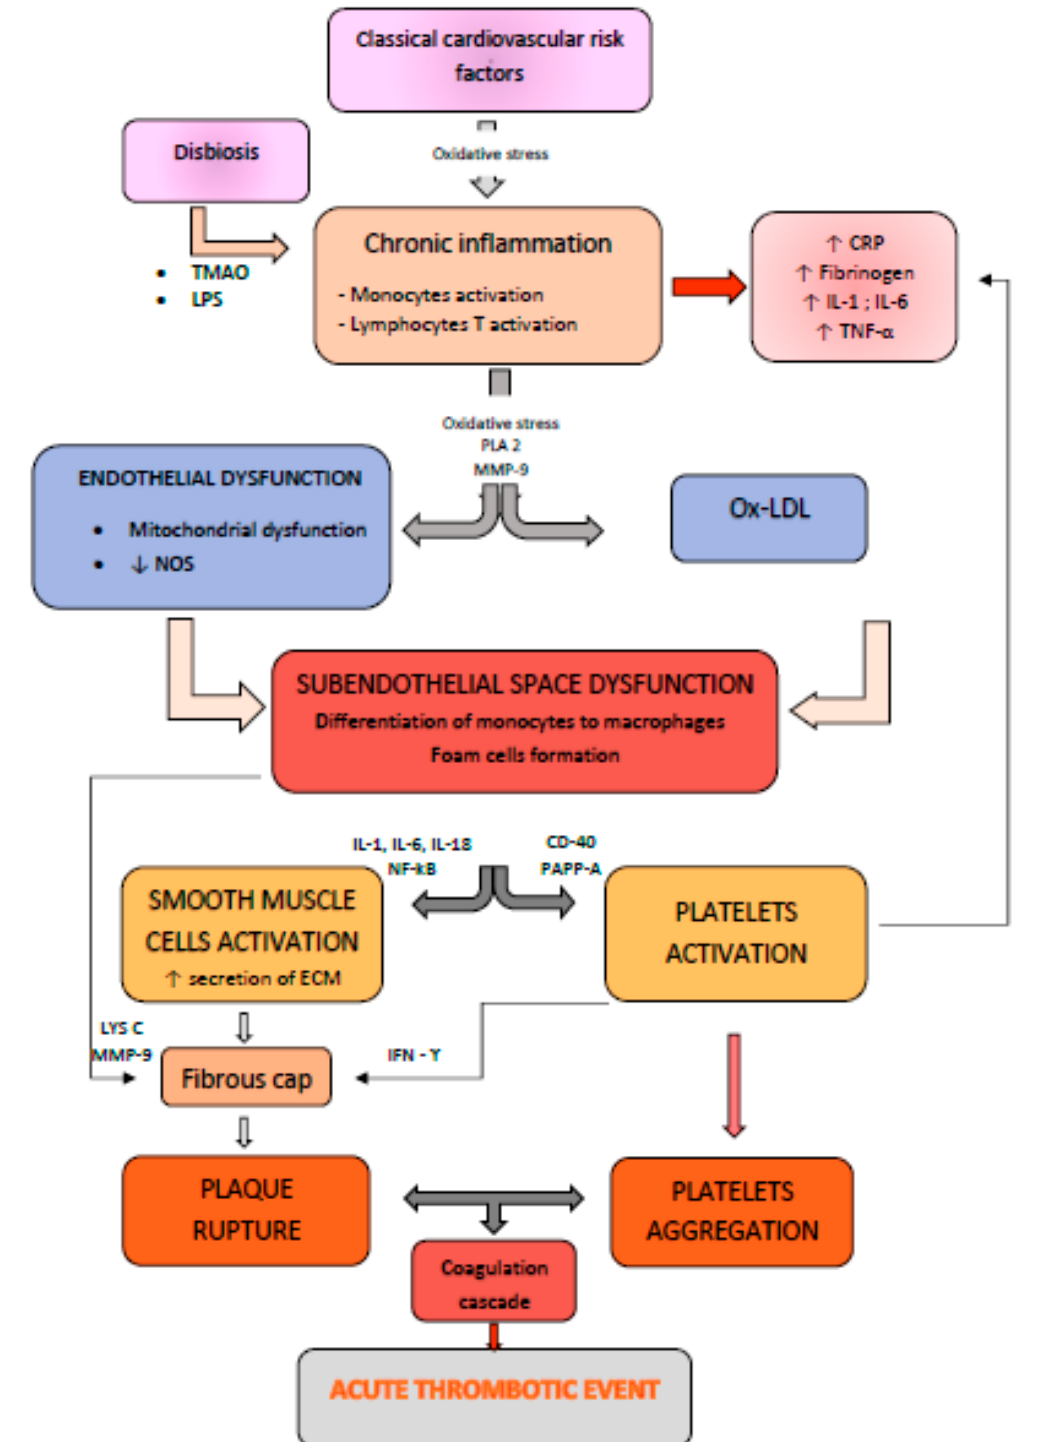
Figure 1. Circulating biomarkers of the vulnerable plaque and the main mechanisms involved in atherosclerotic plaque development. CRP-C, reactive protein; IFN- γ , Interferon- γ ; IL-1, Interleukin-1; IL-18, Interleukin-18; IL-6, Interleukin-6; LPS, lipopolysaccharide; LYS-C, lysozyme c; MMP-9, matrix metalloproteinase-9; NOS, nitric oxide species; PAPP-A, pregnancy associated plasma protein A; PLA-2, Phospholipase A2; TMAO, Trimethylamine-N-oxide; TNF- α , Tumor necrosis factor alpha.